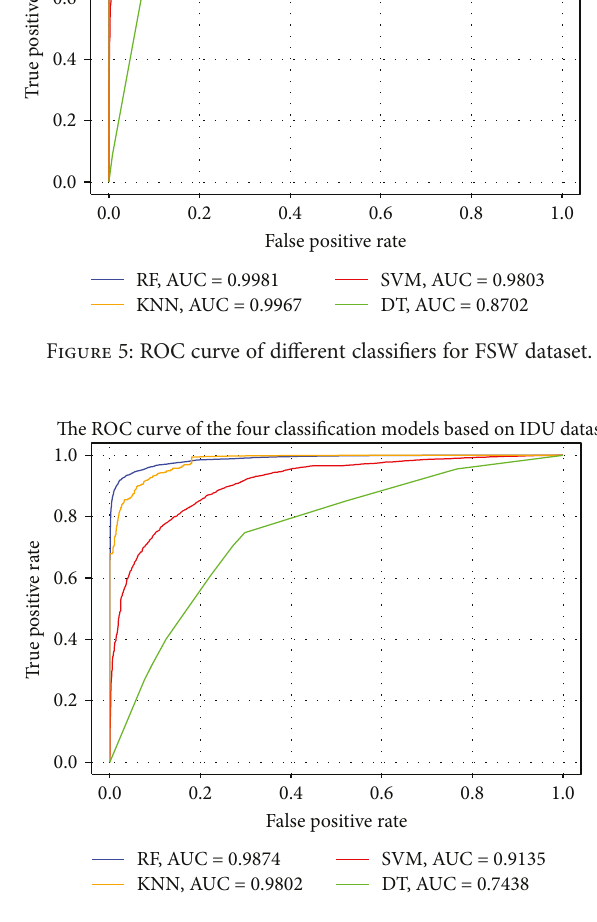
Figure 6: ROC curve of di ff erent classi fi ers for IDU dataset.